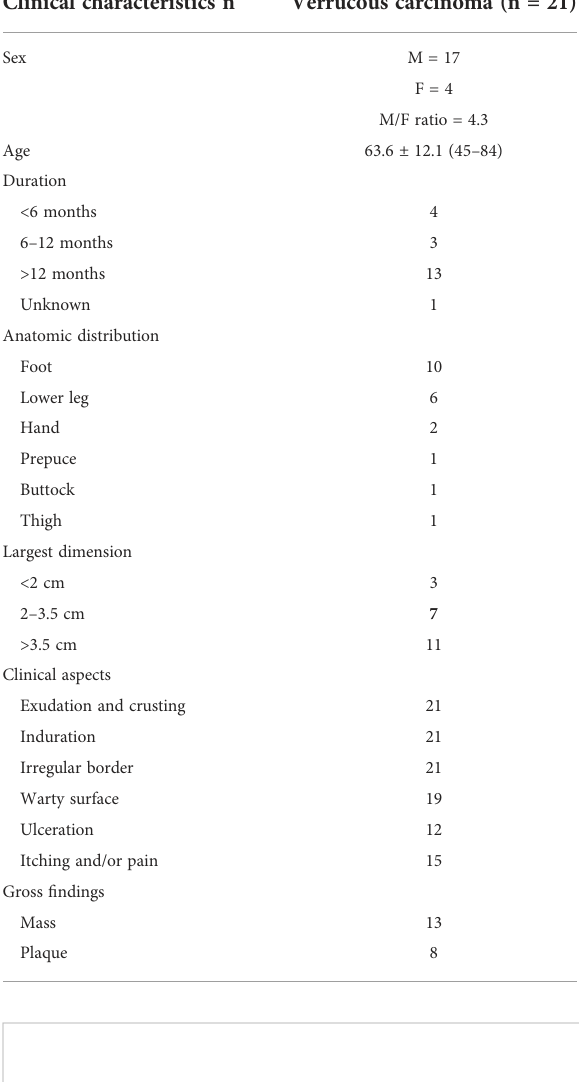
TABLE 1 Epidemiologic and clinical aspects of verrucous carcinoma. Clinical characteristics n